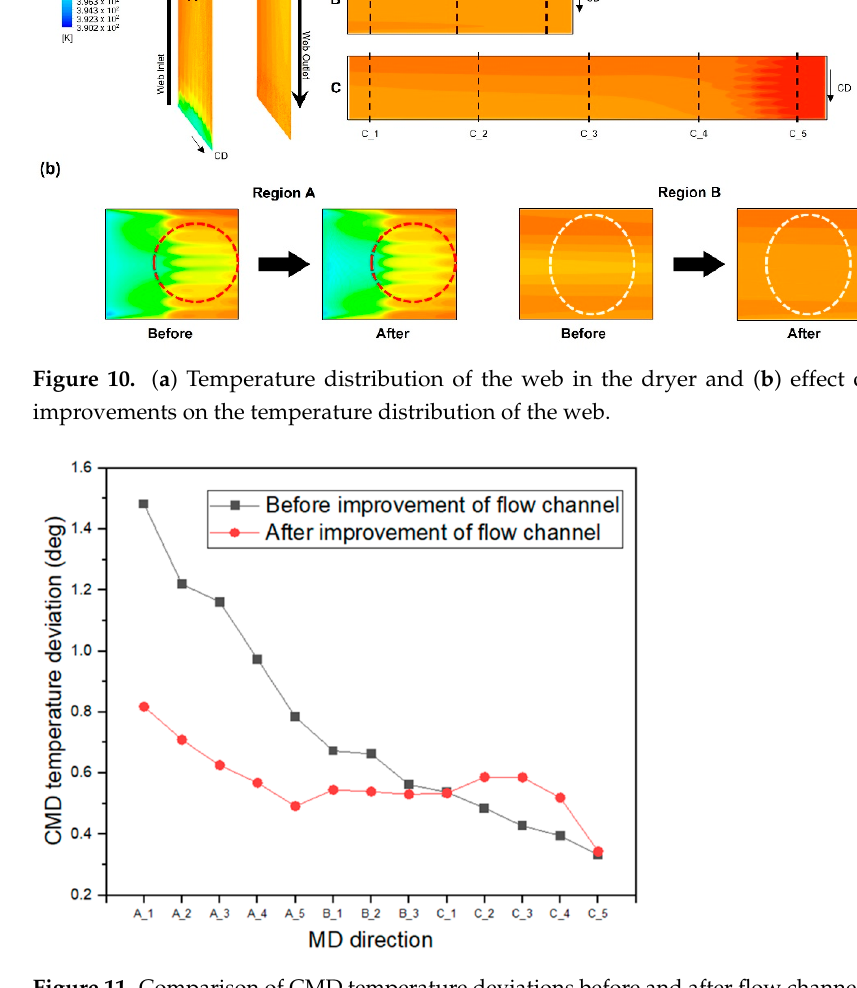
Figure 11. Comparison of CMD temperature deviations before and after flow channel improvements.